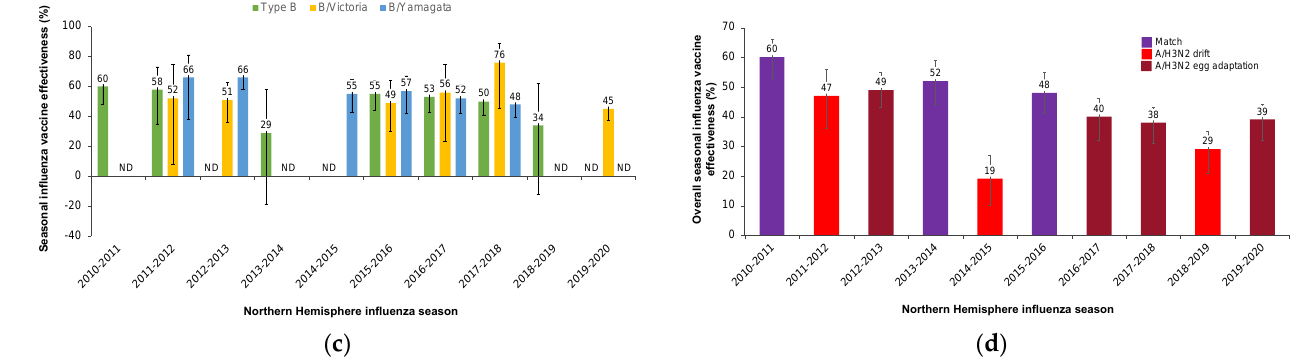
Figure 1. Seasonal influenza vaccine effectiveness in the US as estimated by the Centers for Disease Control and Prevention (CDC) [15–25]. ( a ) Proportions of identified virus types, subtypes, and lineages by year. ( b ) Adjusted vaccine effectiveness for influenza A strains. ( c ) Adjusted vaccine effectiveness for influenza B strains. ( d ) Adjusted overall seasonal effectiveness. Error bars for ( b – d ) indicate adjusted 95% confidence interval. ND, no data. Mismatched seasons tend to be associated with higher rates of hospitalizations and deaths due to influenza, even in years with higher vaccine effectiveness (Figure 2) [15–24,26–29]. Egg adaptation has previously been documented to occur in up to 55% of H3N2 strains [30]. However, influenza burden of disease in any given season strain(s), influenza vaccine coverage, the immunogenicity of the vaccine, the level of vac- cines response in various population groups (e.g., the elderly) and imprinting effects [31,32].